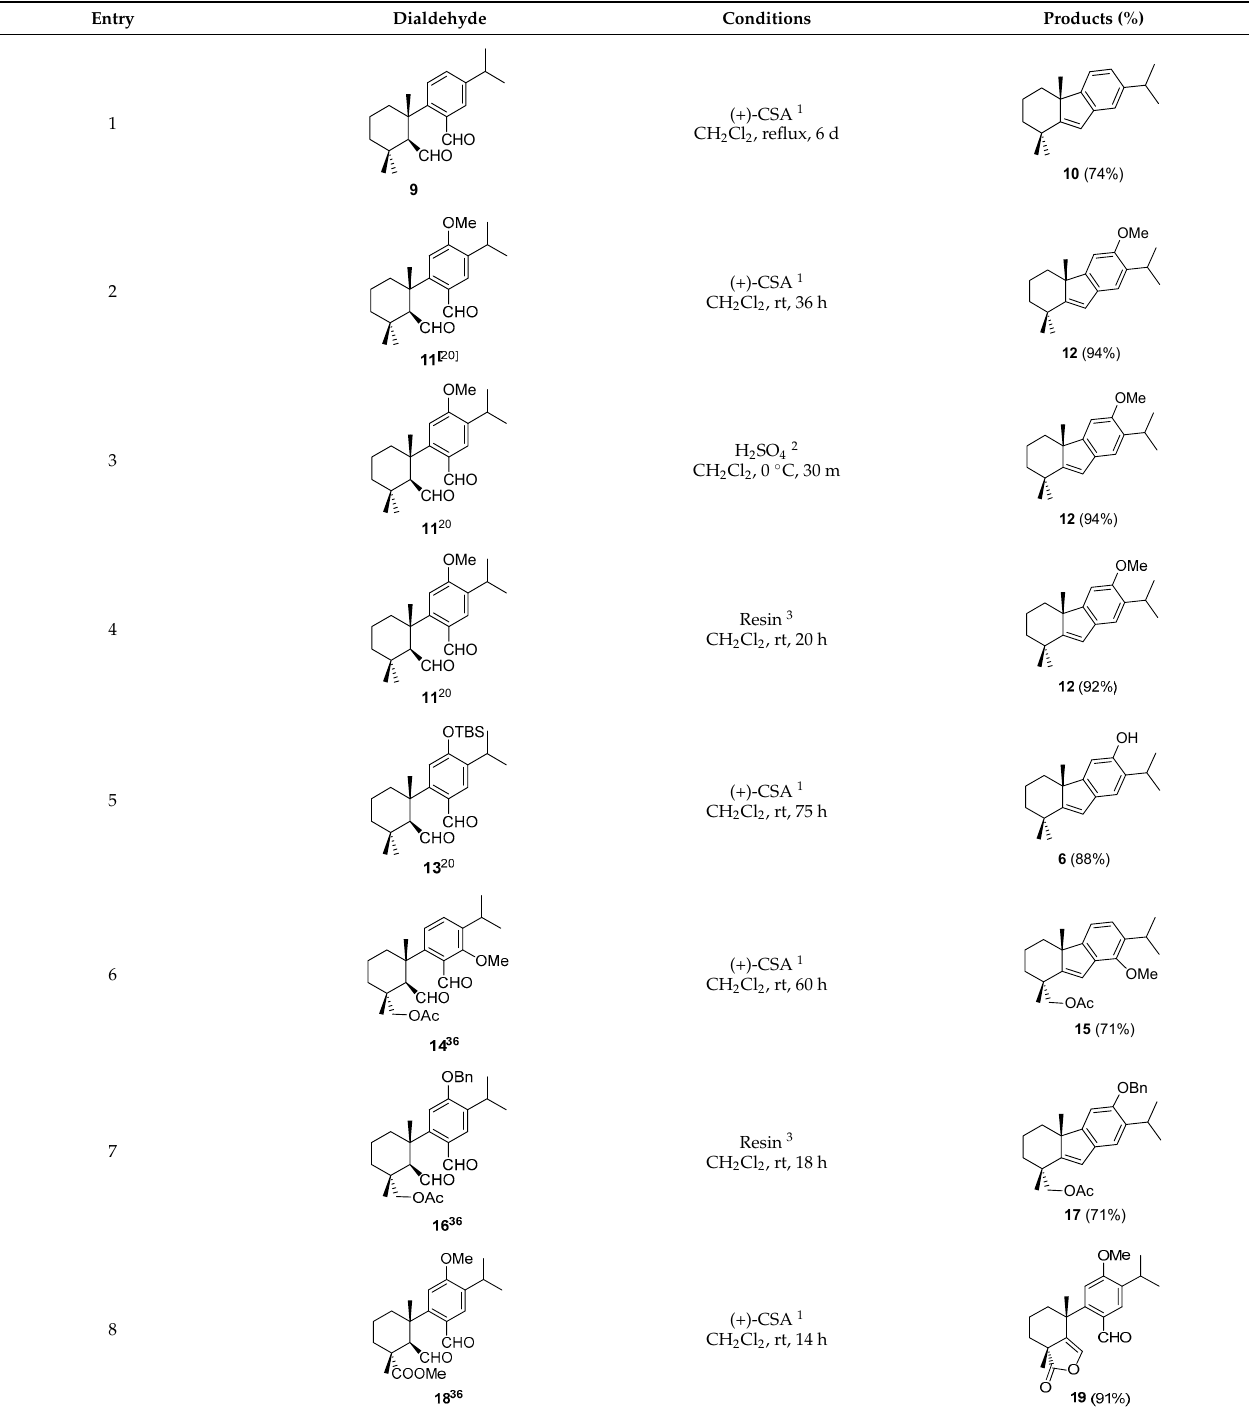
Table 2. Reaction of seco-abietane dialdehydes 9 , 11 , 13 , 14 , 16 , 18 , and 21 under acidic conditions. Entry Dialdehyde Conditions Products ( % )